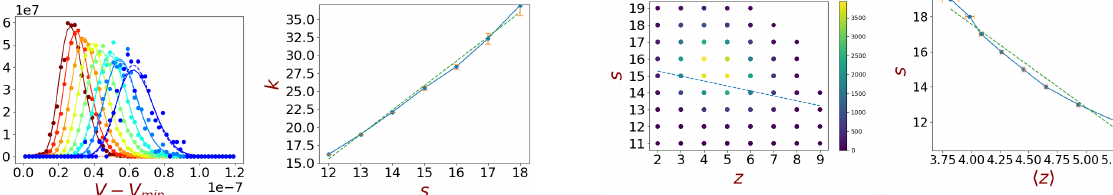
Figure 1: Distributions of Voronoï cell volumes classified by their number of faces s . Solid lines represent the k- gamma distribution with k v and χ calculated from Eq. (4) while dotted lines are the least squares fitting to a k-gamma function (left). Number of elementary cells per Voronoï cell k v as a function of s (right).